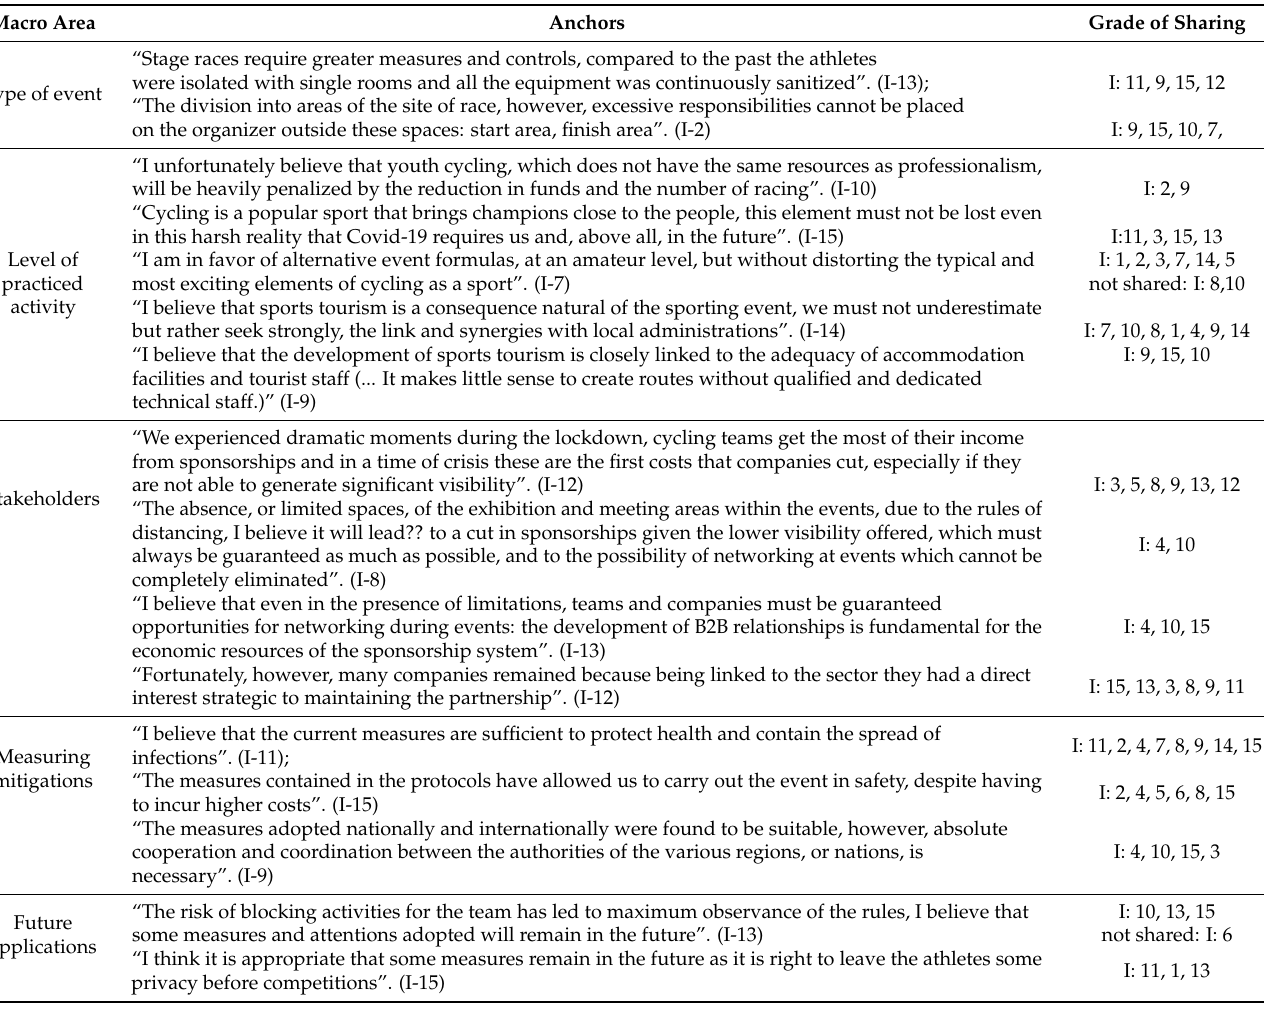
Table 3. Categorization and anchor